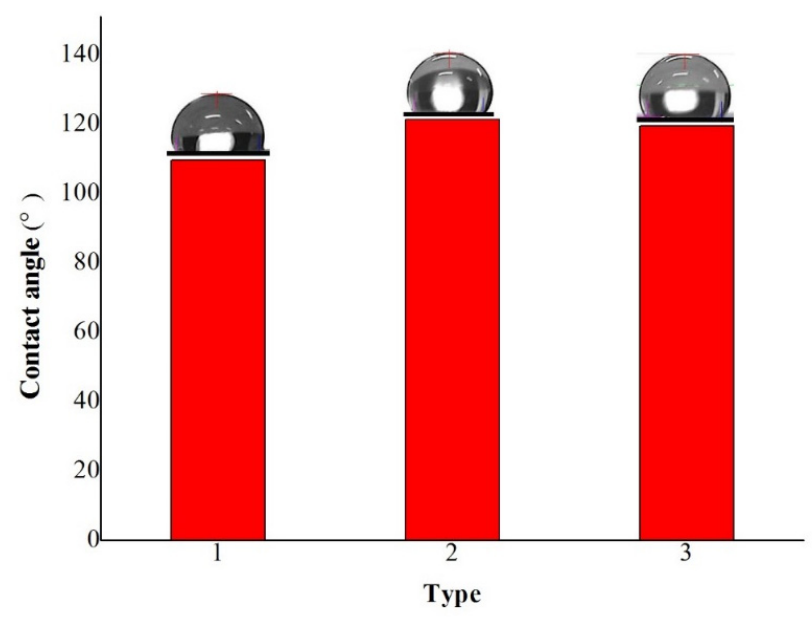
Figure 4. Contact angle of composite materials with different depositions (1:3–0, 2:3–2, 3:4–2). Table 8. Relation between the number of deposition and contact